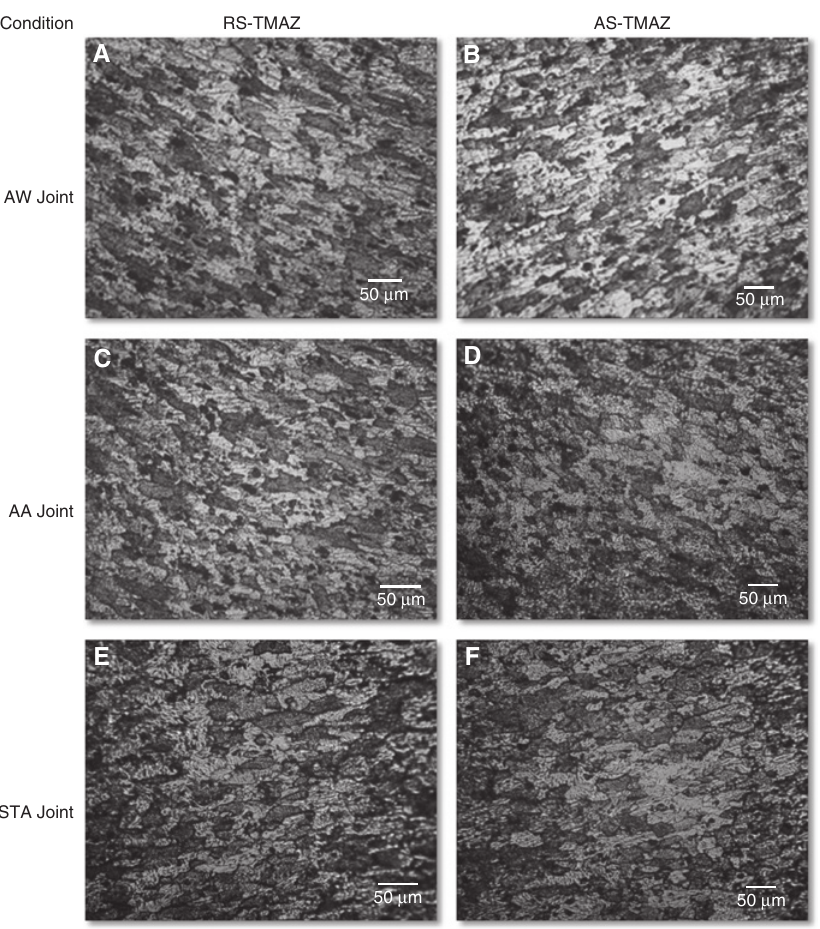
Figure 9: Optical micrograph of AW (A) RS-TMAZ, (B) AS-TMAZ, AA (C) RS-TMAZ, (D) AS-TMAZ, and STA (E) RS-TMAZ, (F) AS-TMAZ.